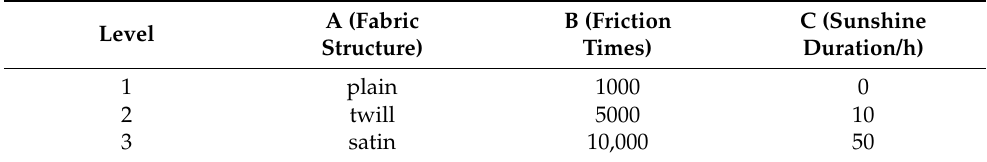
Table 5. Level of factor for fabric structure and external conditions.